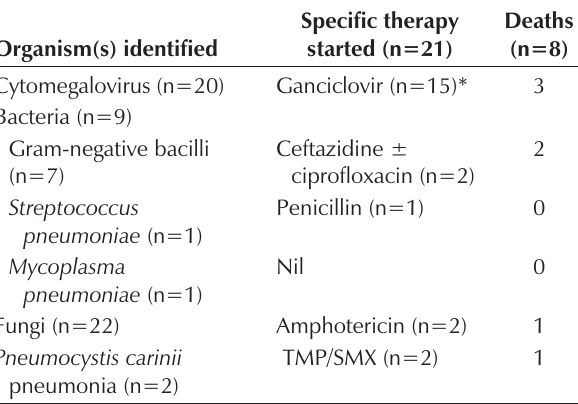
Results of bronchoalveolar lavage in 40 bone marrow trans- plant recipients who underwent bronchoscopy